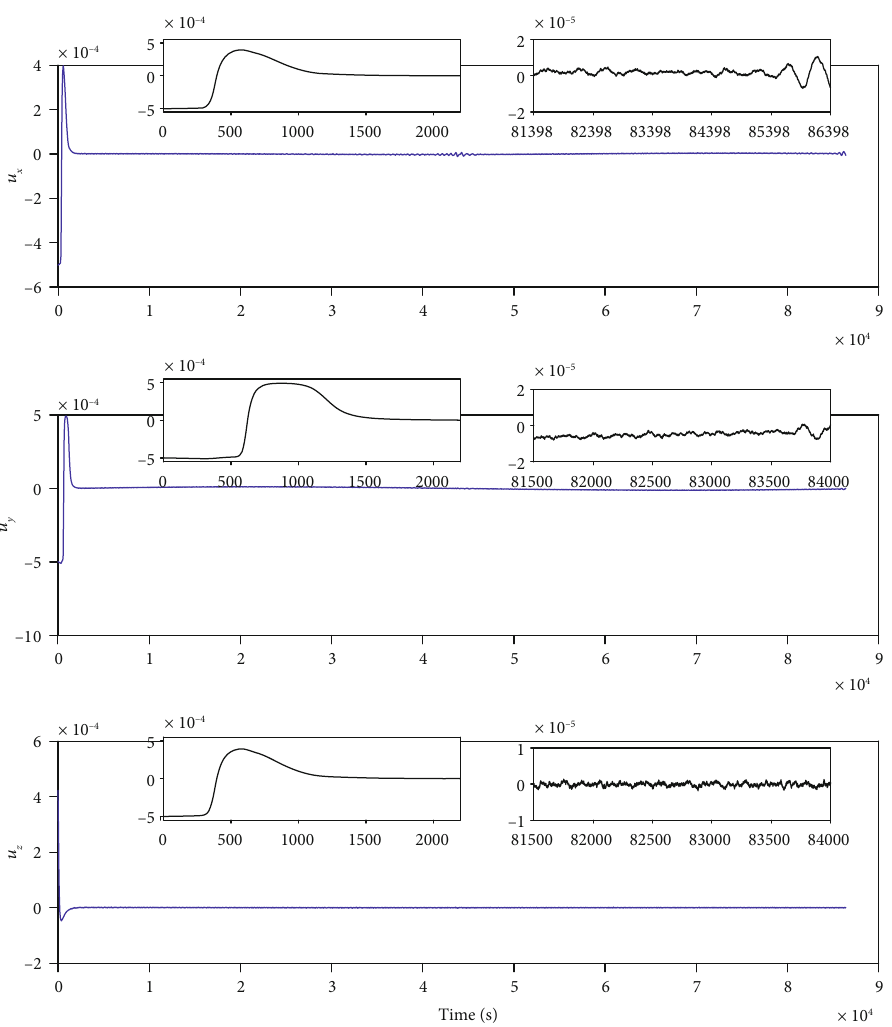
Figure 13: Controller output